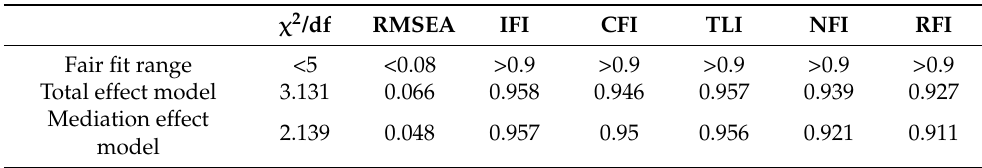
Table 4. Total effect model and mediation effect model fit